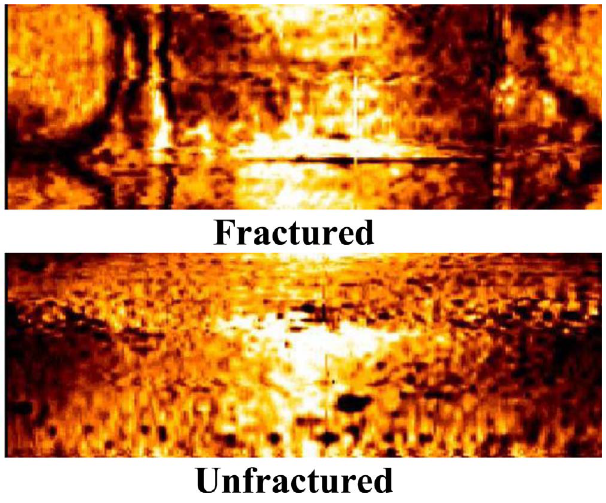
Figure 5. Formation electrical image log images.